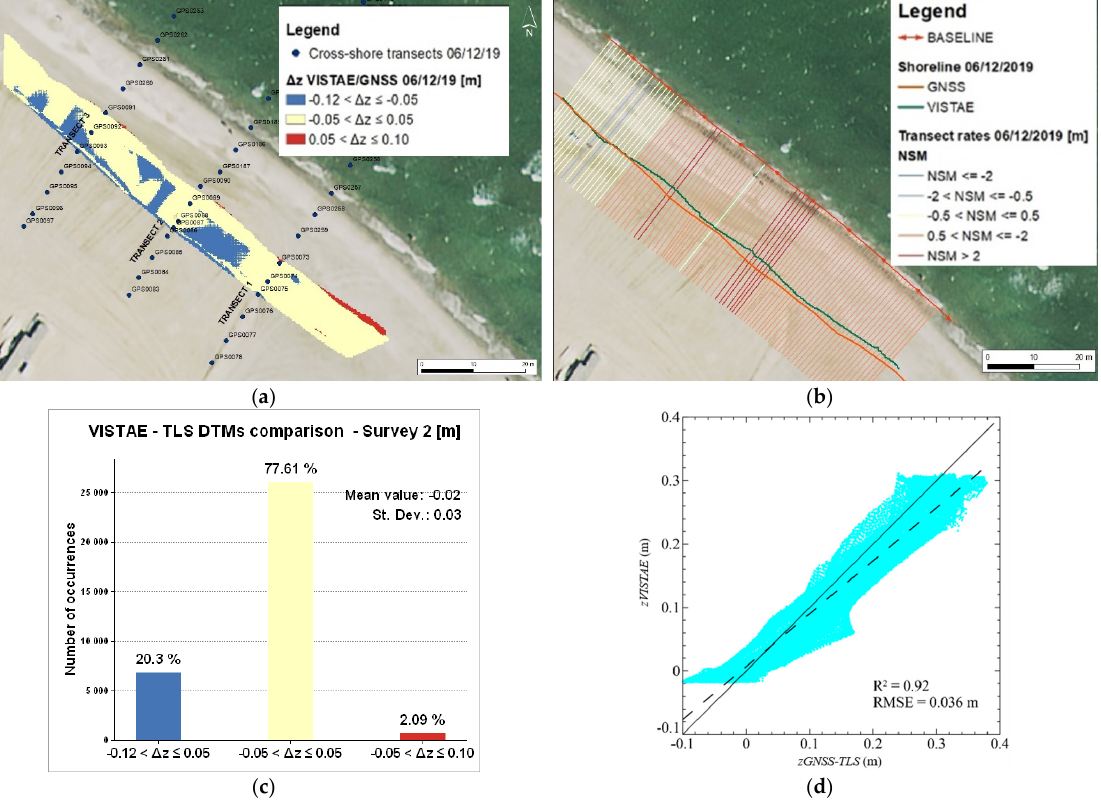
Figure 6. ( a ) Height difference between the low-cost camera (VISTAE) and GNSS elevation models obtained from survey 2 (6 December 2019); mean value and standard deviation are ( − 0.02 ± 0.03) m. ( b ) Comparison between the shoreline (zero contours) extracted by GNSS survey (orange line) and by low-cost camera (VISTAE) green line. The transect colors represent the Net Shoreline Movement (NSM) calculated with the DSAS tool. ( c ) Histogram reporting classes of Δ z distribution as percentages. ( d ) Scatter plot with linear regression parameters (dashed line) between VISTAE and GNSS elevations (in m); solid line is the bisector (slope 1:1), while dashed line is a linear fitting of the data; R 2 and RMSE are 0.92 and 0.036 m. Also, cross-shore transects (Figures 6a and 7) were used for comparing the two meth- odologies on punctual, single measures, thus with more precision than the DTM-interpo- lated area. For transects 1 and 2, the elevation differences were Δ z 1 = (0.080 ± 0.001) m and Δ z 2 = (0.068 ± 0.054) m, respectively, while the result of transect 3 showed a very good overlap with Δ z 3 = (0.007 ± 0.026) m (Table 2). The comparison of the VISTAE and GNSS elevations show a very good fit between measures, with an R 2 = 0.92 and an RMSE= 0.036 m (Figure 6d).